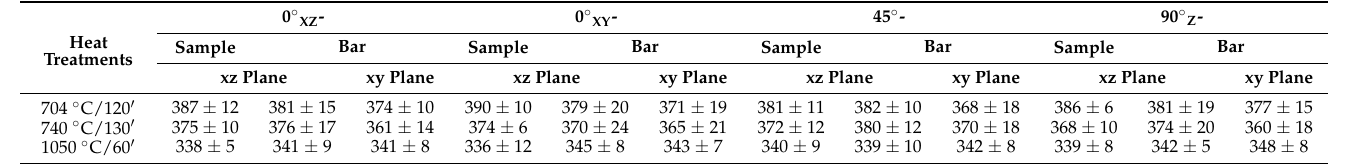
The hardness values measured on bars heat-treated at 704 °C/120 ′ and 740 °C/130 ′ agree with those obtained on the heat-treated tensile samples (Figure 12). As a matter of fact, the 704 °C/120 ′ and 740 °C/130 ′ bars show the same microstructure of the tensile sam- ples. Instead, considering the effects induced by the SHT at 1050 °C, the average HV 0.5 values of the bars are slightly higher than those obtained on the tensile sample due to the different microstructures (Figures 5 and 6). Figure 13 shows the HV 0.1 values of the